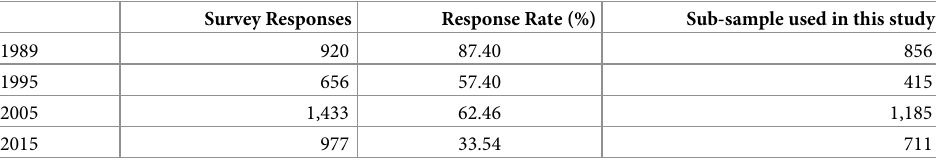
Table 2. Total responses and number of observations used in this study, by